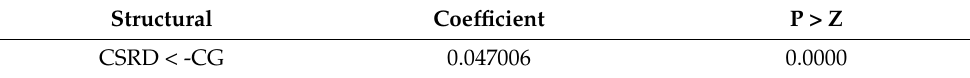
Table 2. Result of corporate governance and corporate social responsibility disclosure.